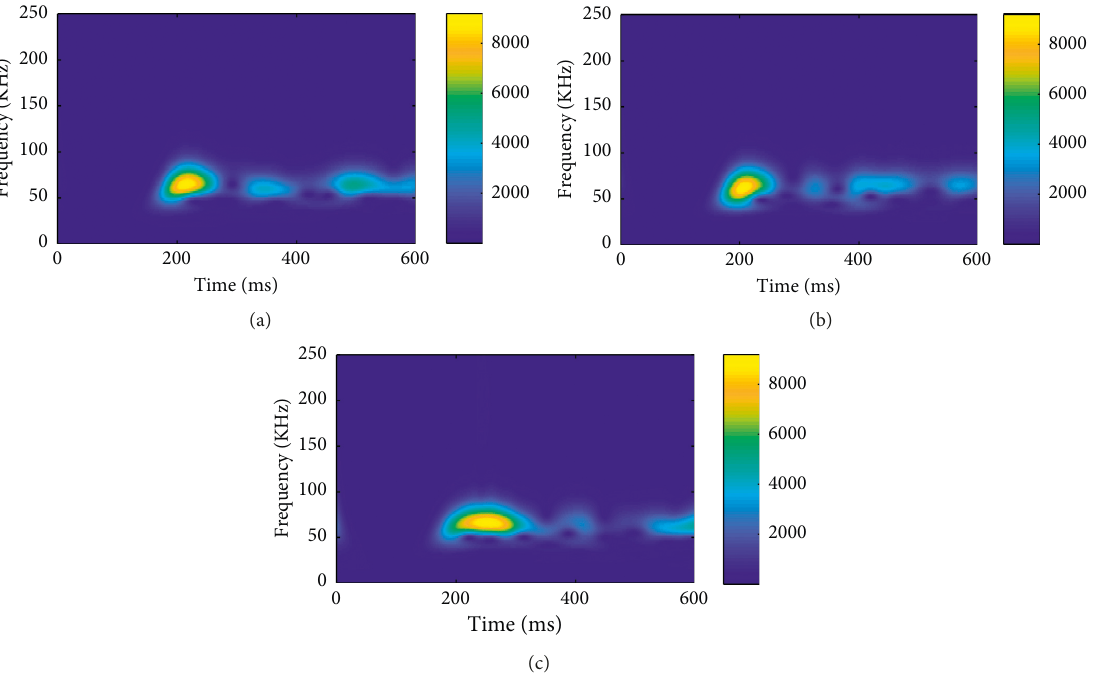
Figure 10: Energy spectrum of time-frequency S transform at the intact concrete position: (a) 1st testing signal; (b) 2nd testing signal; (c) 3rd testing signal.